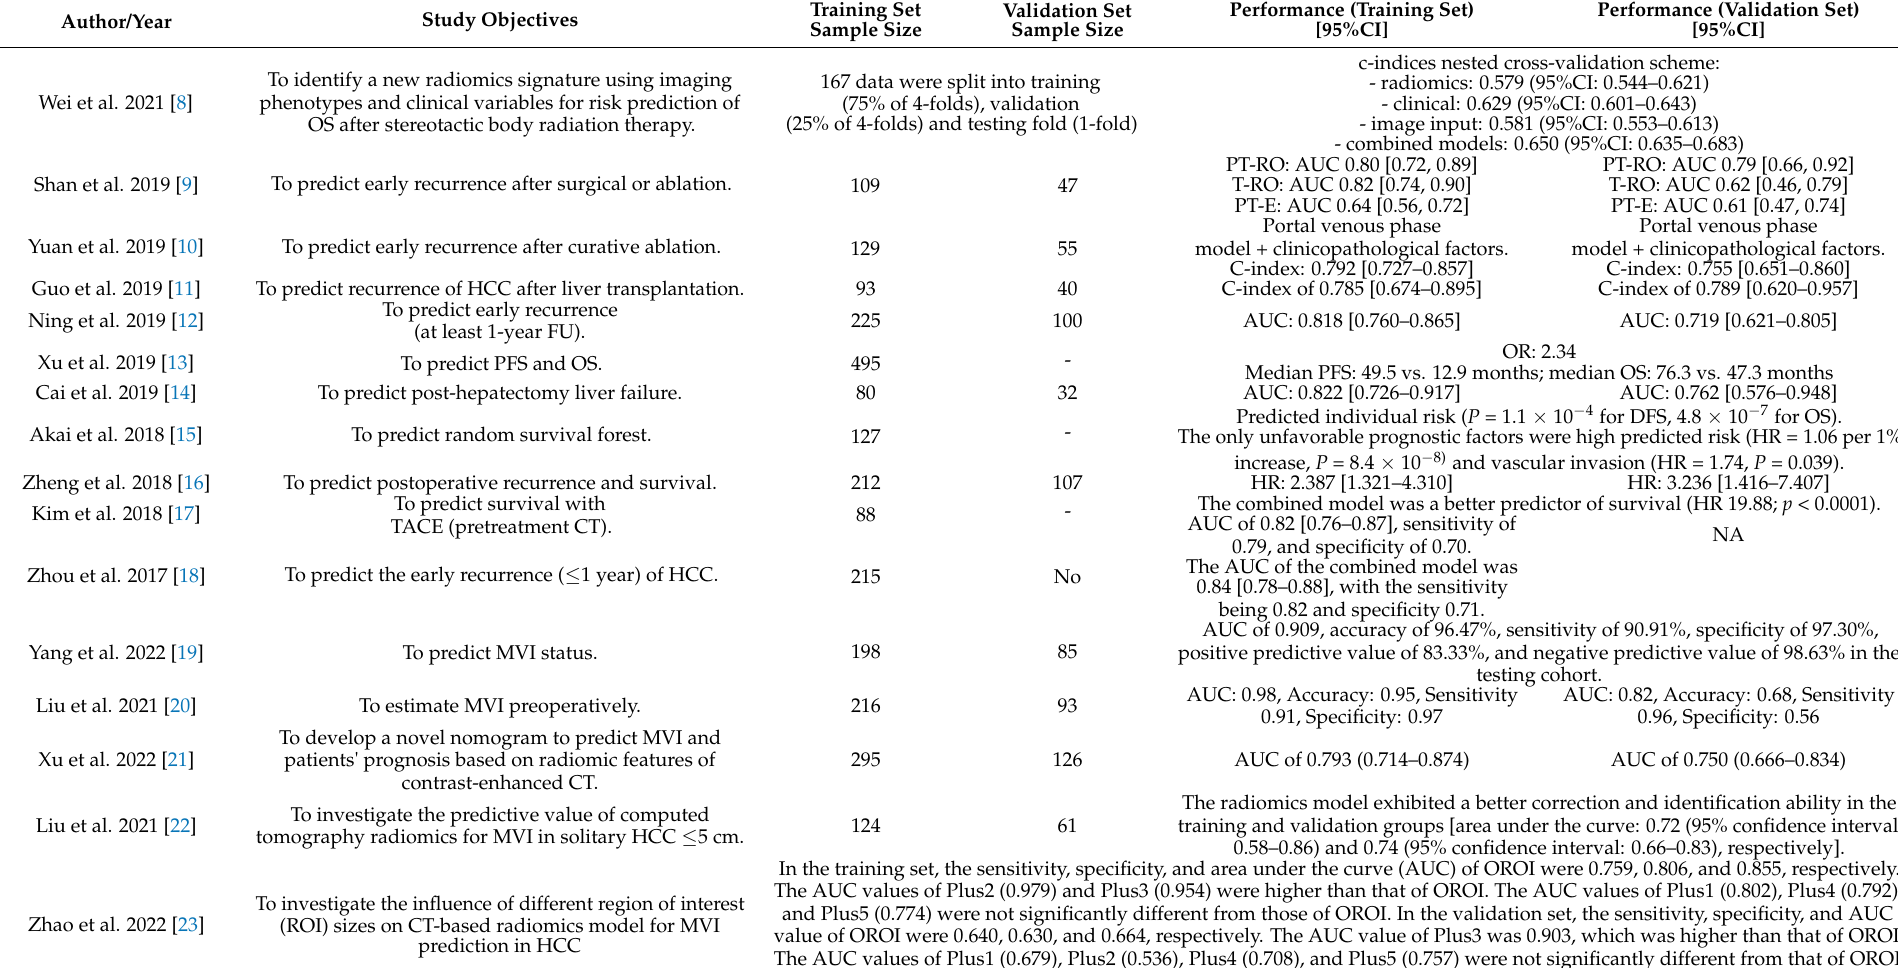
Table 2. Performance of radiomics approaches (using CT features to predict patient